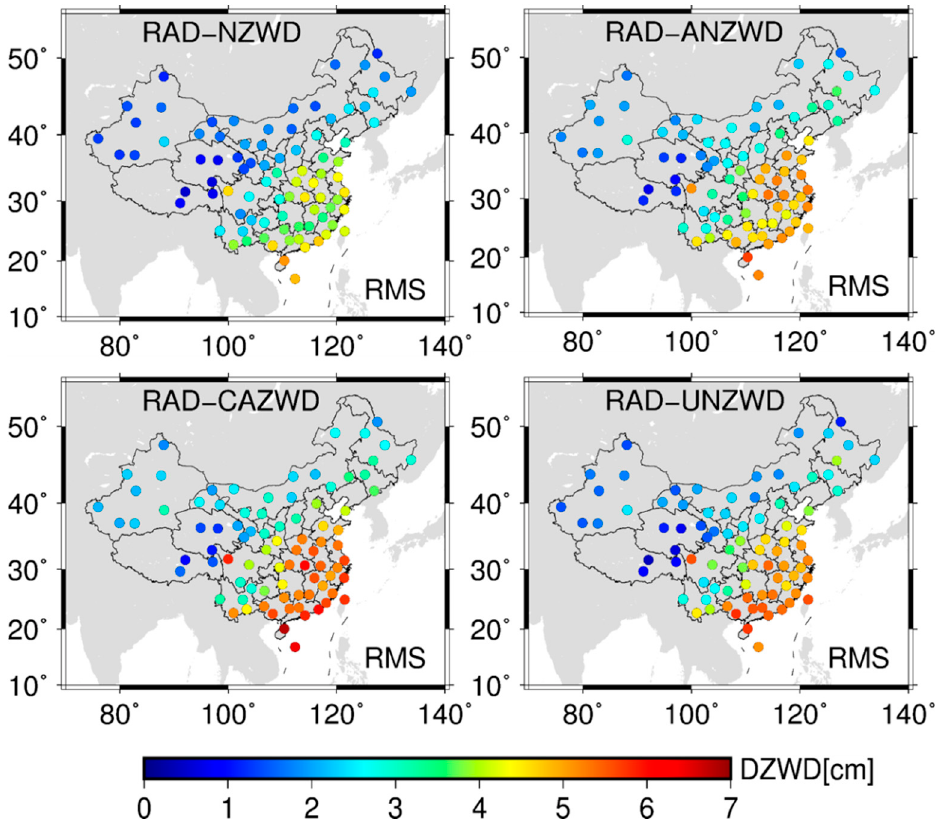
Figure 4. Statistical results of the analysis of deviation between RAD and model-derived ZWD. See main text for explanation of abbreviations. main text for explanation of